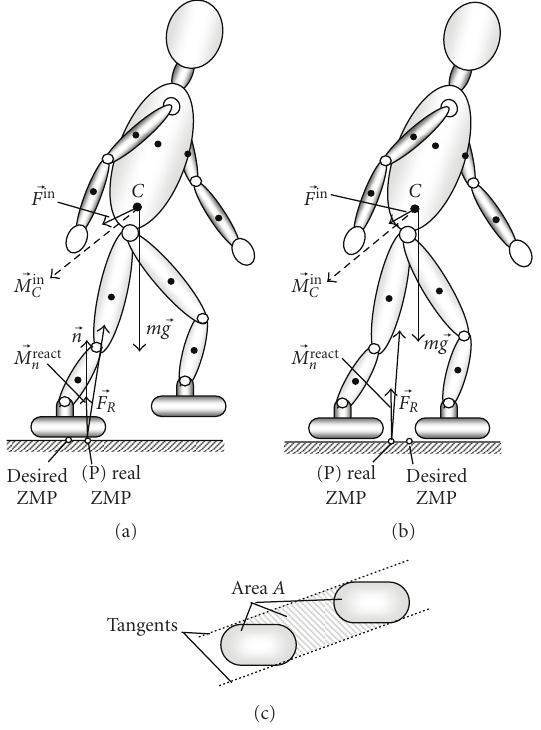
Figure 14: Desired and realized ZMP during (a) the single support and (b) the double support